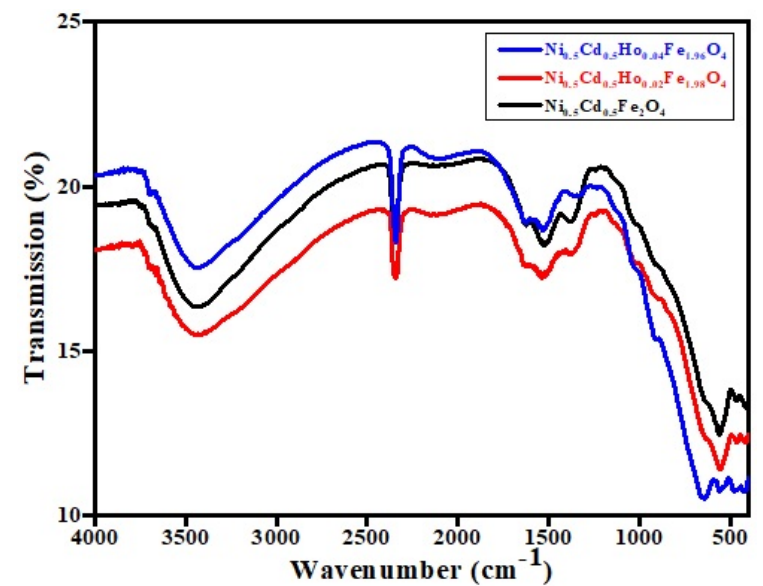
Figure 3. FTIR graph of samples of Ni 0.5 Cd 0.5 Ho x Fe 2-x O 4 (x = 0, 0.02, and 0.04).